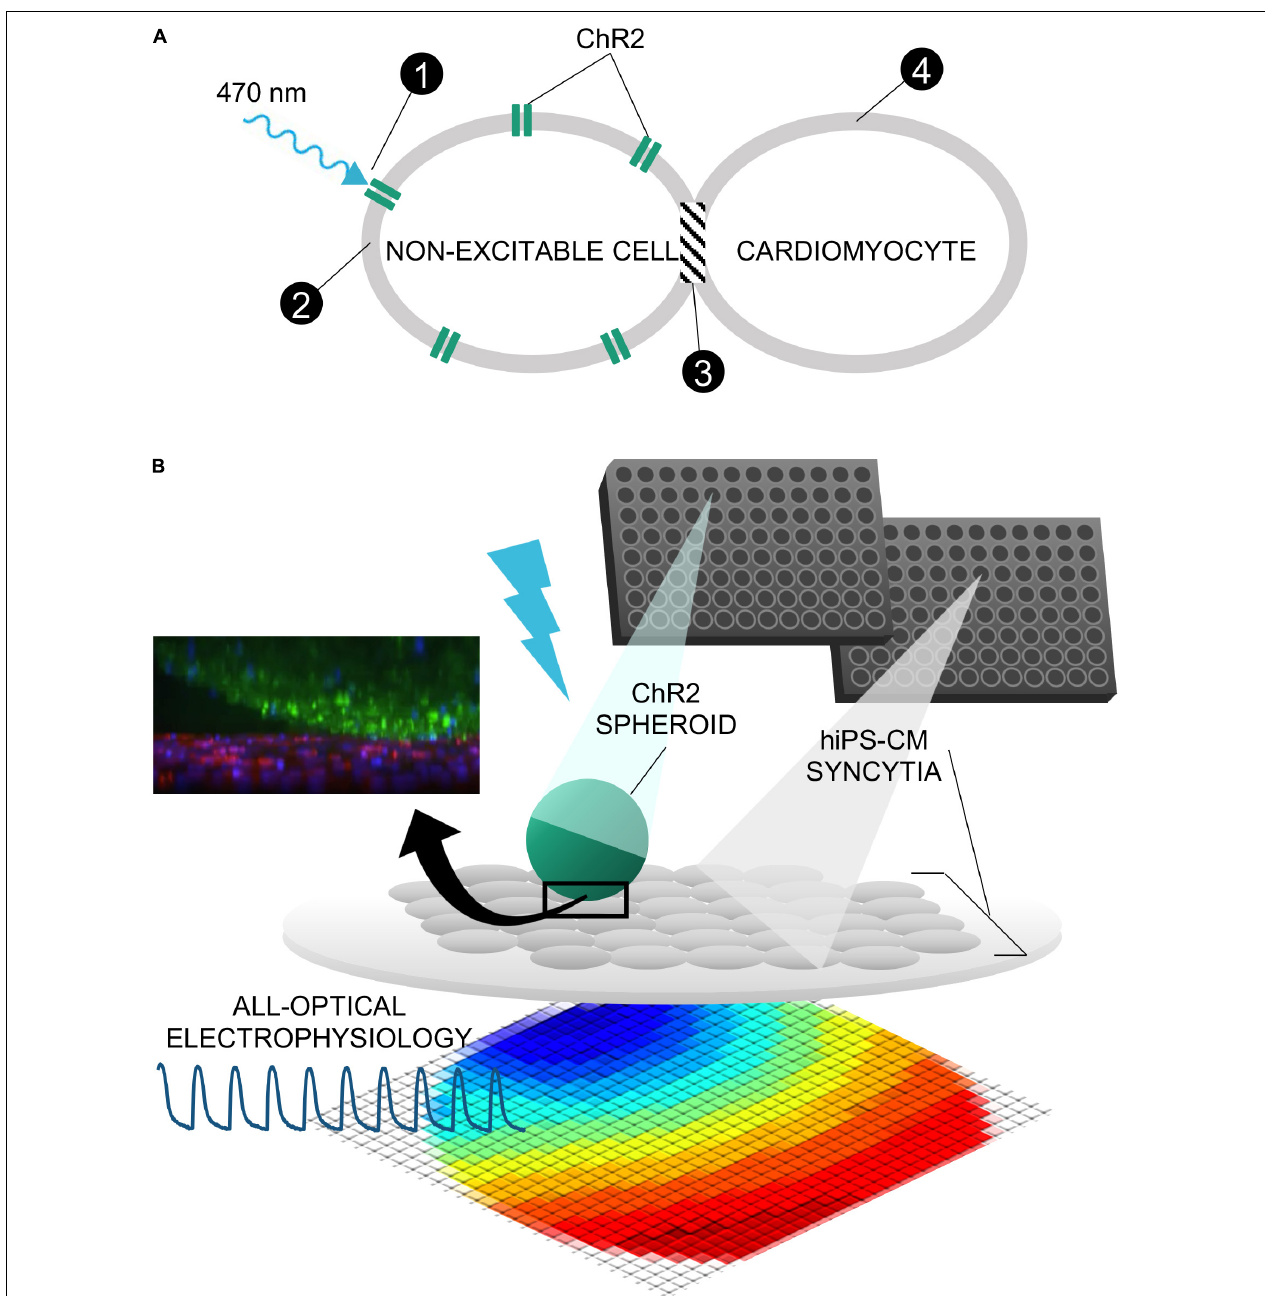
FIGURE 1 | Tandem-cell-unit approach using three-dimensional spark cell spheroids. (A) Illustrated is the tandem-cell-unit (TCU) approach. (1) Blue light (470 nm) induces conformational change in ChR2 expressed in a non-excitable cell resulting in (2) inward current and an elevated membrane potential in the non-excitable cell. Because there exists (3) some form of coupling between the non-excitable and cardiac cells, (4) the system evokes an action potential and subsequent contraction in the cardiomyocytes. (B) Shown is the deployment of TCU using a spheroid structure and cardiac tissue – a schematic representation of a ChR2-expressing three-dimensional cell spheroid on top of a two-dimensional layer of hiPS-CM tissue. Confocal microscopy captured the relative positioning (ChR2-HEKs labeled green and hiPSC-CMs labeled red) as shown in the inset.